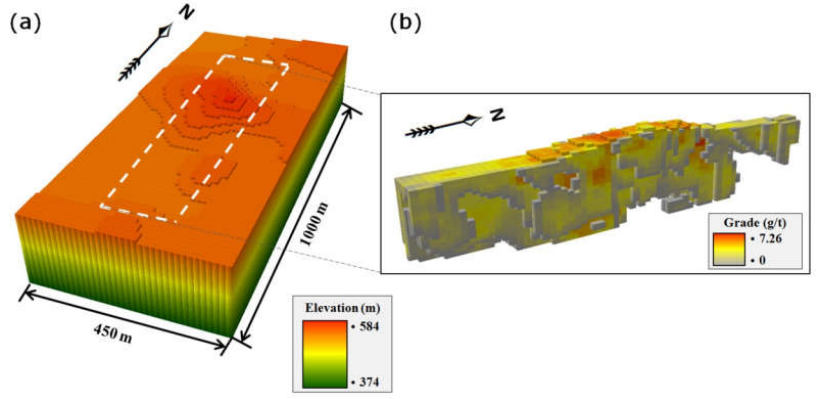
Figure 10. Three‐dimensional view of the study area. ( a ) Block model of gold deposits. ( b ) Gold ore body marking the grade of gold.